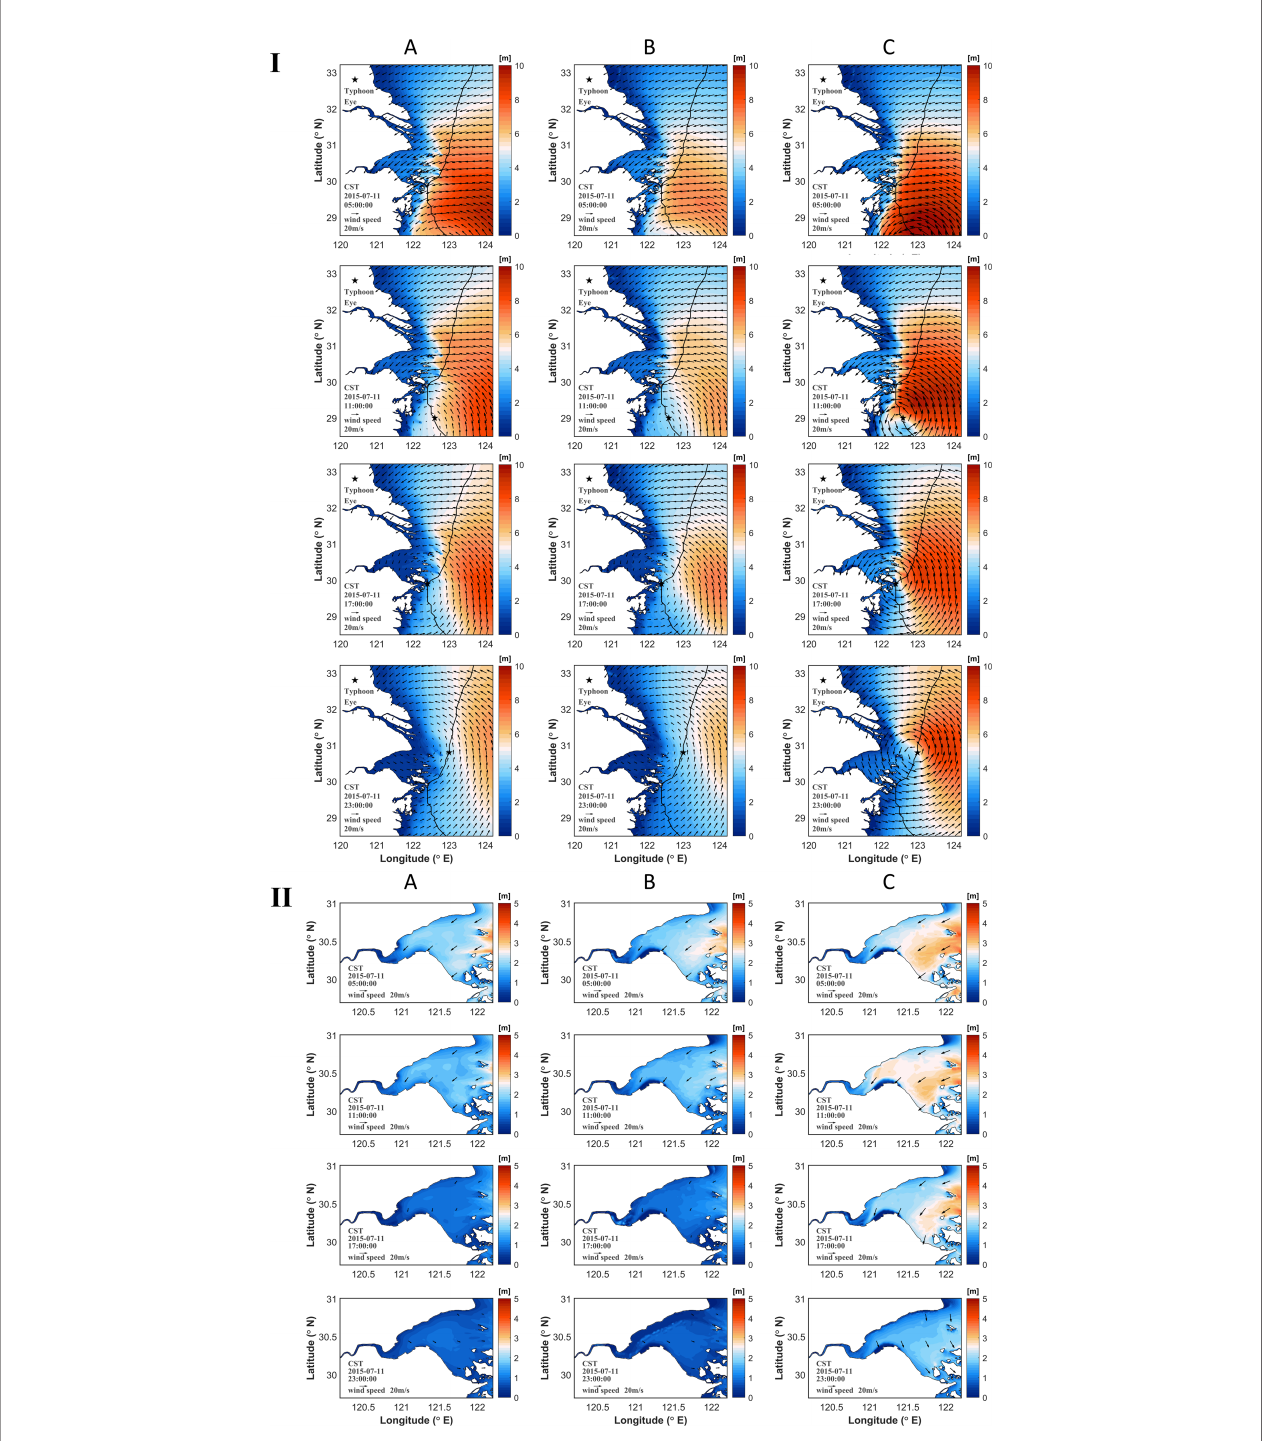
FIGURE 10 | Signi fi cant wave heights (a) in Case 8 with the large domain in He et al. (2020), (b) in Case 9 with the small domain in Figure 1A (wind fi eld not re- constructed), (c) in Case 0 with the small domain in Figure 1A (re-constructed wind fi eld). Vectors indicate wind fi eld and contours indicate signi fi cant wave heights. (I) and (II) are for the large area and the HZB,